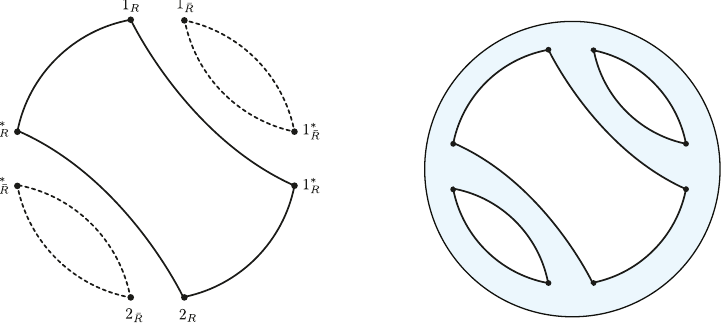
Figure 2 . On the left, the diagram corresponding to the amplitude h R, R | ρ, e i for n = 2 . The lines along the circumference are the boundary conditions imposed by the bra, while the lines of the interior are prescribed by the particular permutation, σ = e in this case. Each solid loop corresponds to a factor of n R and each dashed loop corresponds to a factor of n . On the right, the double-line R diagrammatic representation of the amplitude. In this representation, k ( η − 1 e ) + k ( e ) = F − 1 = 3 , where F is the number of white faces (with the exterior included). In general, k ( η − 1 σ ) + k ( σ ) = F − 1 = E − V − 2 g + 1 from the Euler-Poincaré formula, where E is the number of edges and V is the number of vertices of the blue ‘polygon’, while g is the genus of the surface in which the polygon is embedded. The inequality (2.19) follows from E = 3 n and V = 2 n